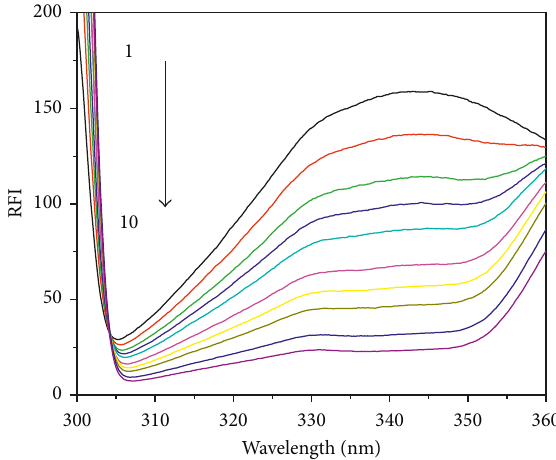
Figure 4: The Stern–Volmer plot of HSA fluorescence quenching by [Ag(I)(Hnor) 2 ]ClO 4 at 295nm. Inset: plot of log ( F 0 a function of log